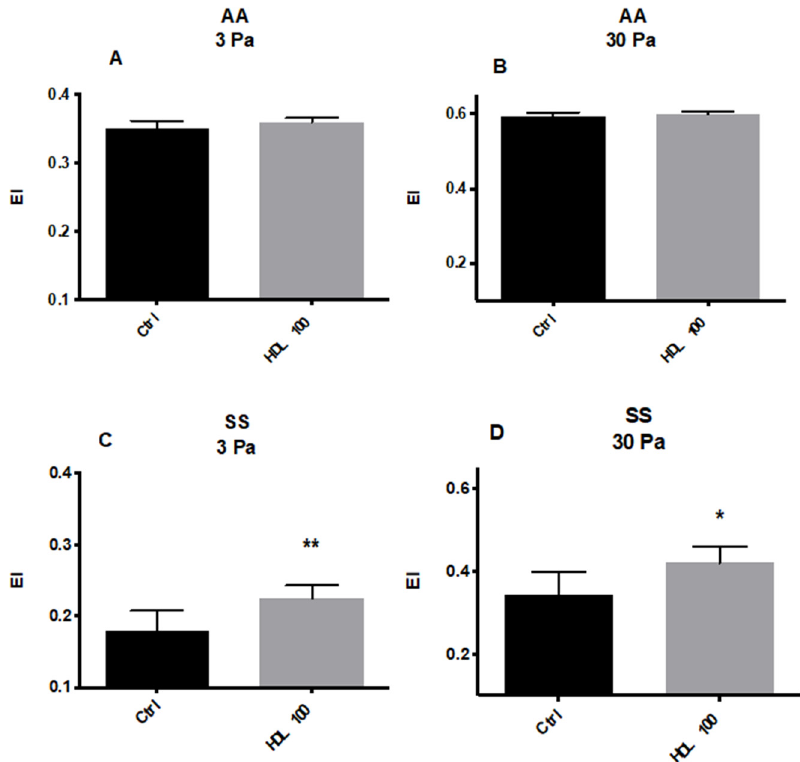
Figure 1. RBC Deformability from Healthy volunteers (HbAA) measured at 3 Pa ( A ) and 30 Pa ( B ) after incubation with human HDL (100 µ g/mL). Deformability of RBCs from SCD patients (HbSS) at 3 Pa ( C ) and 30 Pa ( D ) after incubation with human HDL (100 µ g/mL). *, p < 0.05; **, p < 0.01. EI: Elongation Index, NS: not significant.